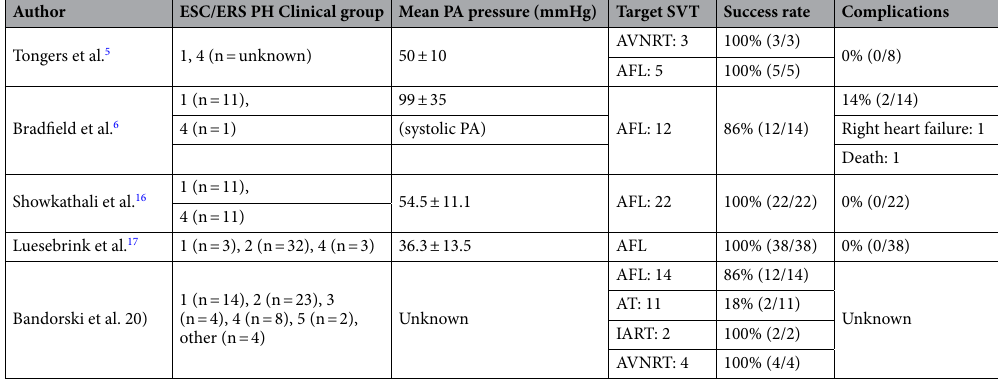
Table 3. Previous literature about RFCA for SVT in patients with pulmonary hypertension. AFL: common atrial flutter, AT: atrial tachycardia, AVNRT: atrioventricular nodal reentrant tachycardia, ERS: European Respiratory Society, ESC: European Society of Cardiology, IART: intra-atrial reentrant tachycardia, PA: pulmonary arterial, PH: pulmonary hypertension, RFCA: radiofrequency catheter ablation, SD: standard deviation, SVT: supraventricular